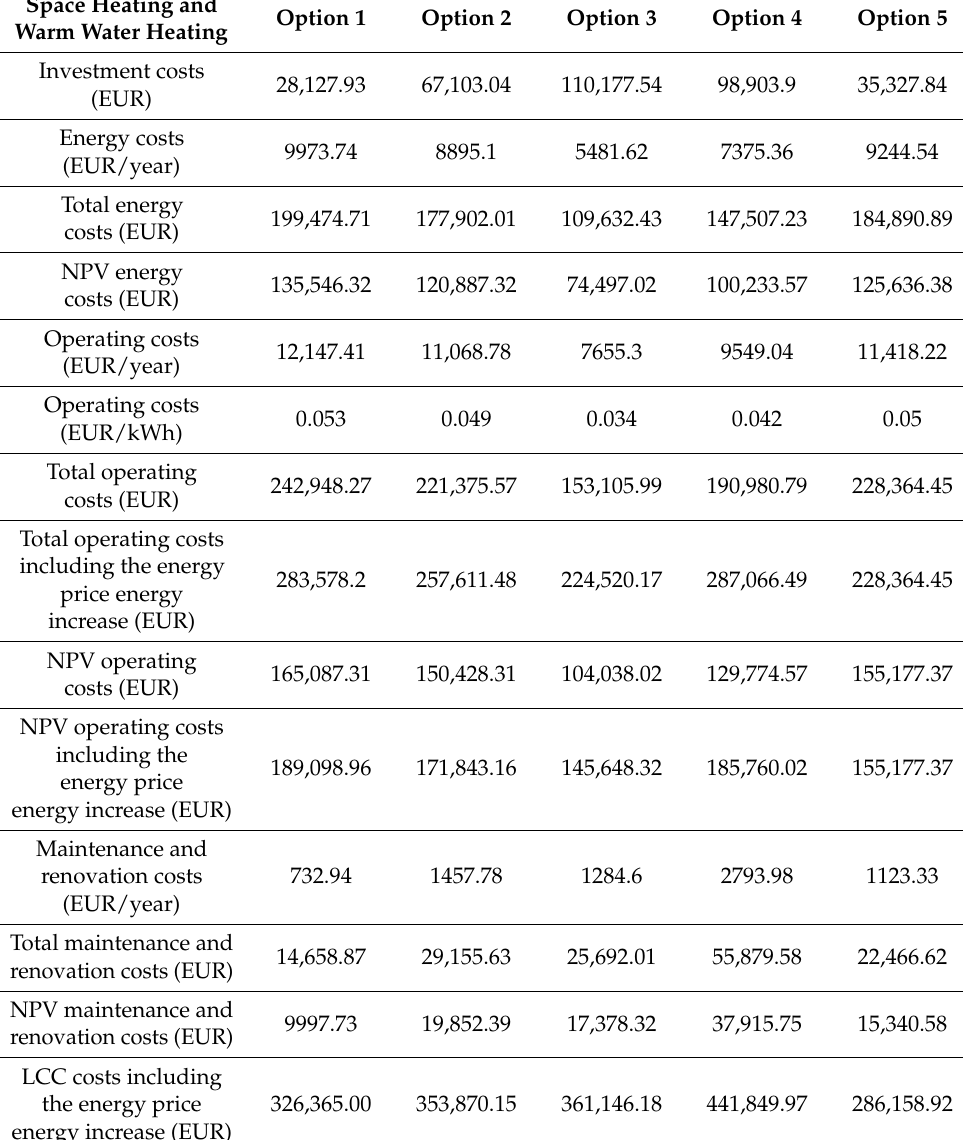
Table 8. Results resulting from the